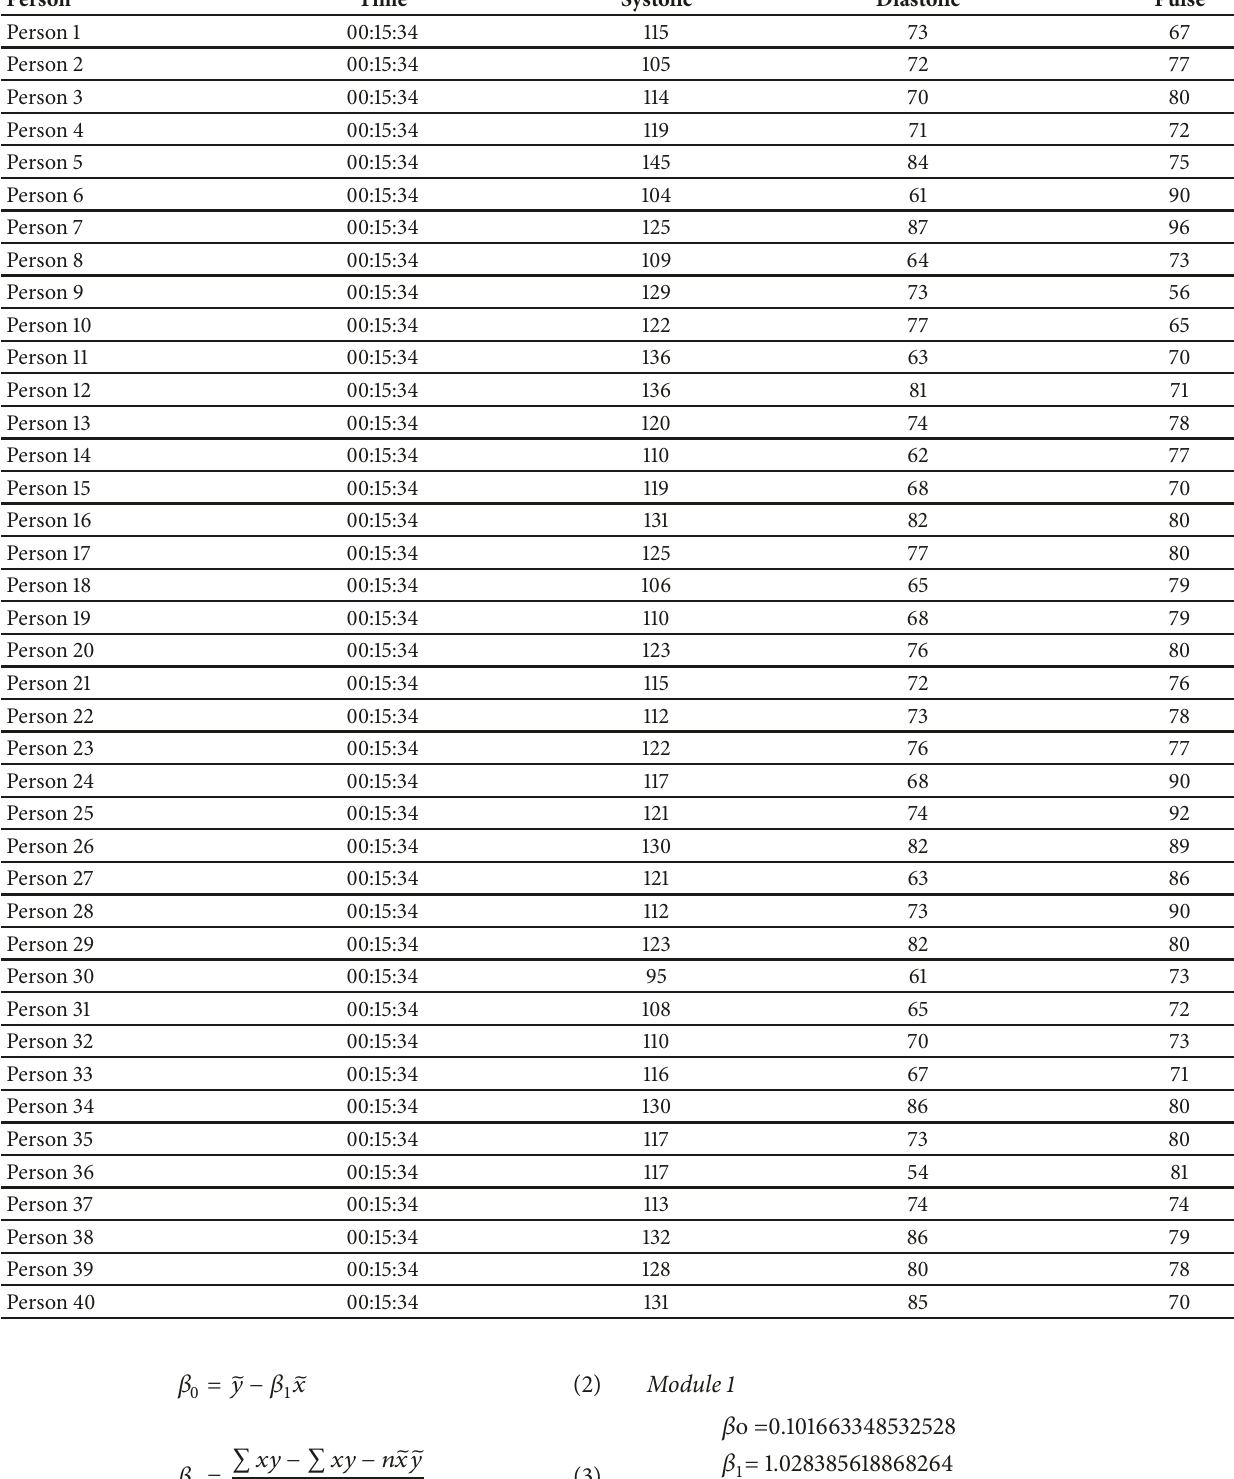
Table 4: Average results of the MNN with